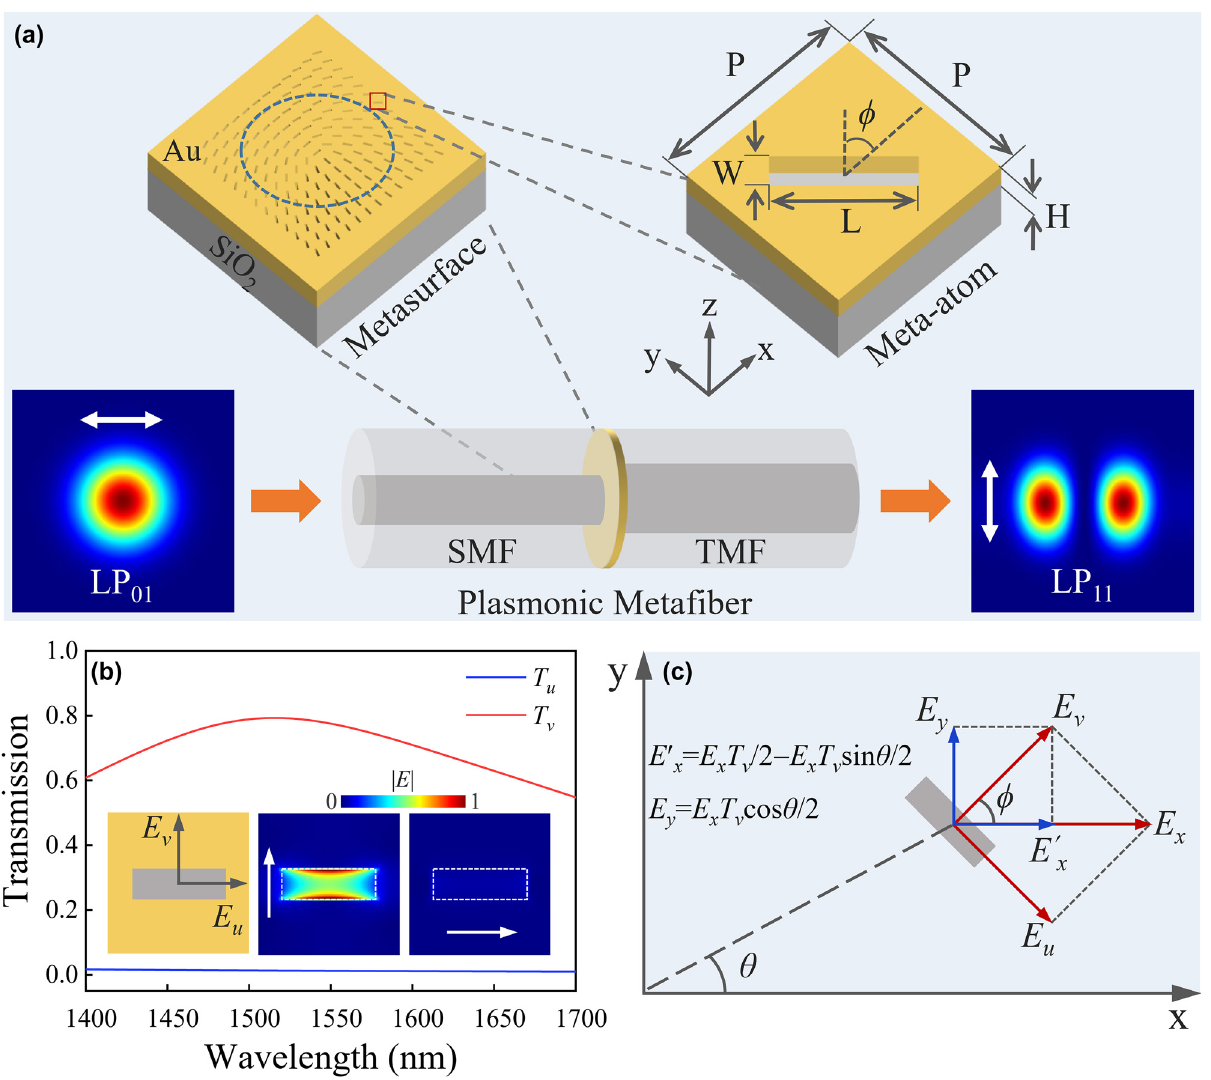
Figure 1: Concept, geometry, and working principle of the plasmonic metafiber. (a) Geometry of the metafiber and metasurface, and schematic of the mode to LP mode. The mode field distributions are the simulated results of metafiber. (b) Simulated transmission and mode conversion from LP 01 11 electric field distributions of a single nanohole when the incident light beam is polarized along the long and short axes of nanohole. (c) Schematic of the working principle of the metasurfaces for mode